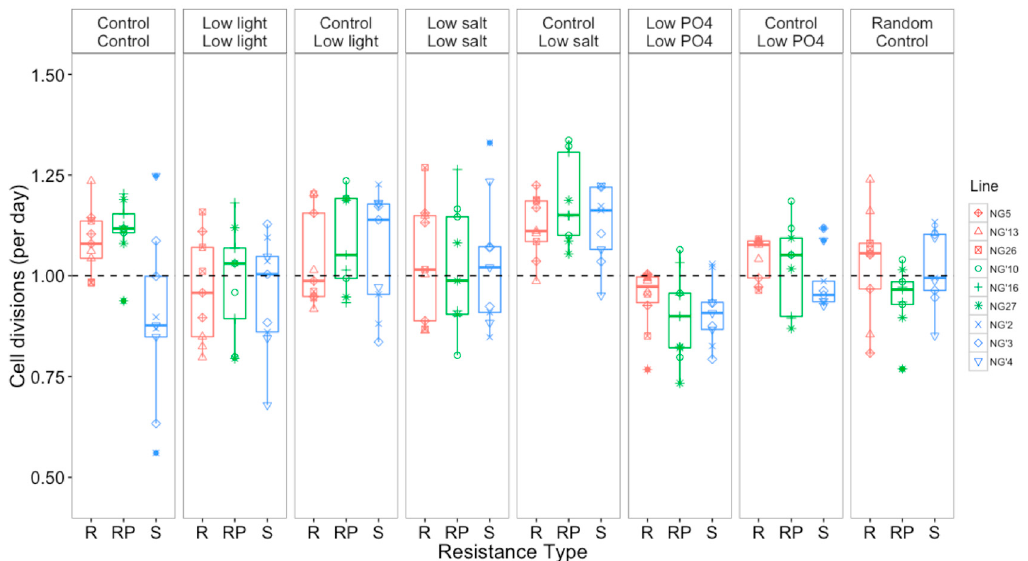
Figure 4. Mean cell divisions per day ( ± SEM). R = resistant, RP = resistant producer, S = susceptible. Each panel represents a growth assay, with cells evolved in the selection environment (top label) and growth rates measured in the assay environment (bottom label). The dashed line indicates, for reference, one cell division per day.